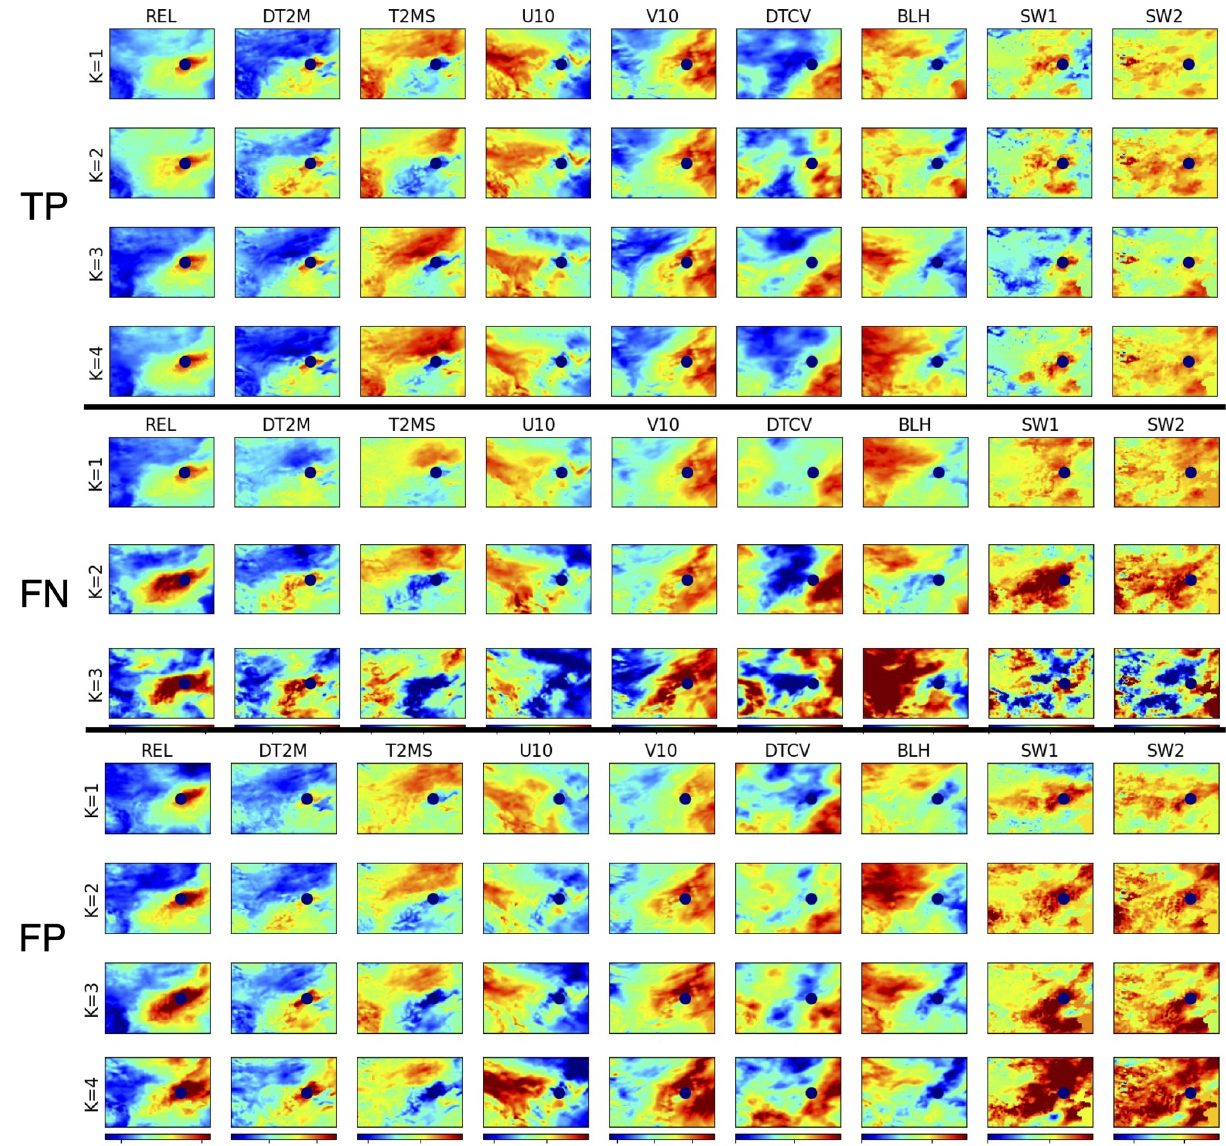
Figure 7. Maps of the nine features in a normalized format for four clusters of true positive (TP) outcomes, three clusters of false negative (FN) outcomes, and four clusters of false positive (FP) outcomes. Here, TP plus FN covers haze events. Results shown are cluster averages for Beijing cases (location marked by navy